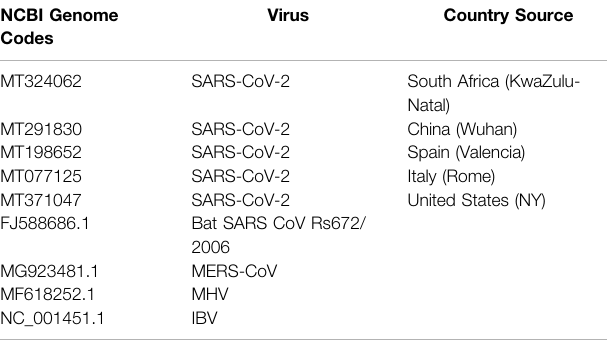
TABLE 1 | Viral genome codes used for the present